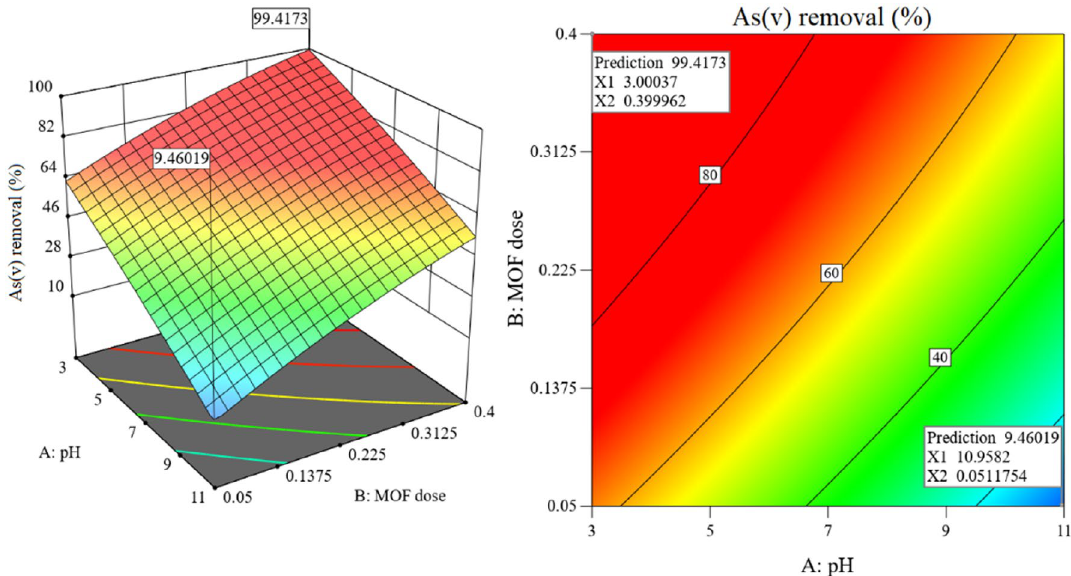
Figure 6. Interaction of pH and MOF dose on system response (As(V) = 2.5 mg/L, Time = 80 min). Design- Expert v13 software was used to create this figure (https:// www. state ase. com/ docs/ v13/).